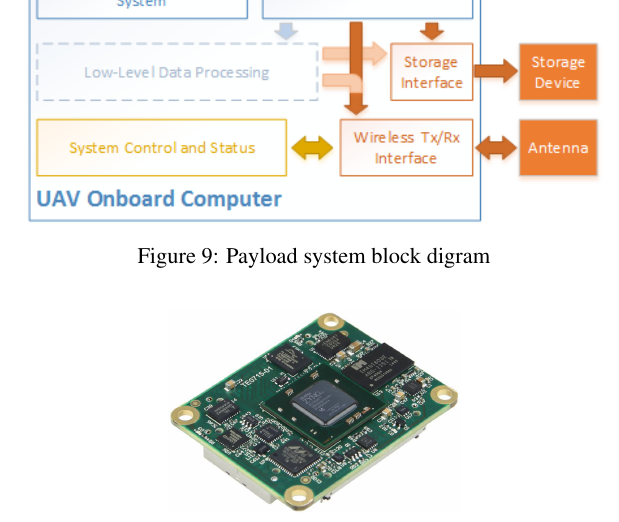
Figure 10: TE0715-03-30 Zynq SoC module XC7Z030